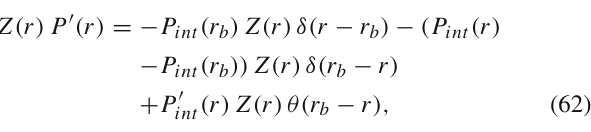
Fig. 10 Theplotshowstheradialdependenceofthefactors Z ( r ) P (cid:3) ( r ) definingtheintegrandin(34).Itshowsthatthelimit r → r − is finite. Thus, the integral vanishes when the width 2 δ of the integration region tends to zero. This result checks the satisfaction of the solvability condition Z ( r ) , again the factor Z ( r ) P (cid:3) ( r ) in the integrand of the con- dition (34), can be written as